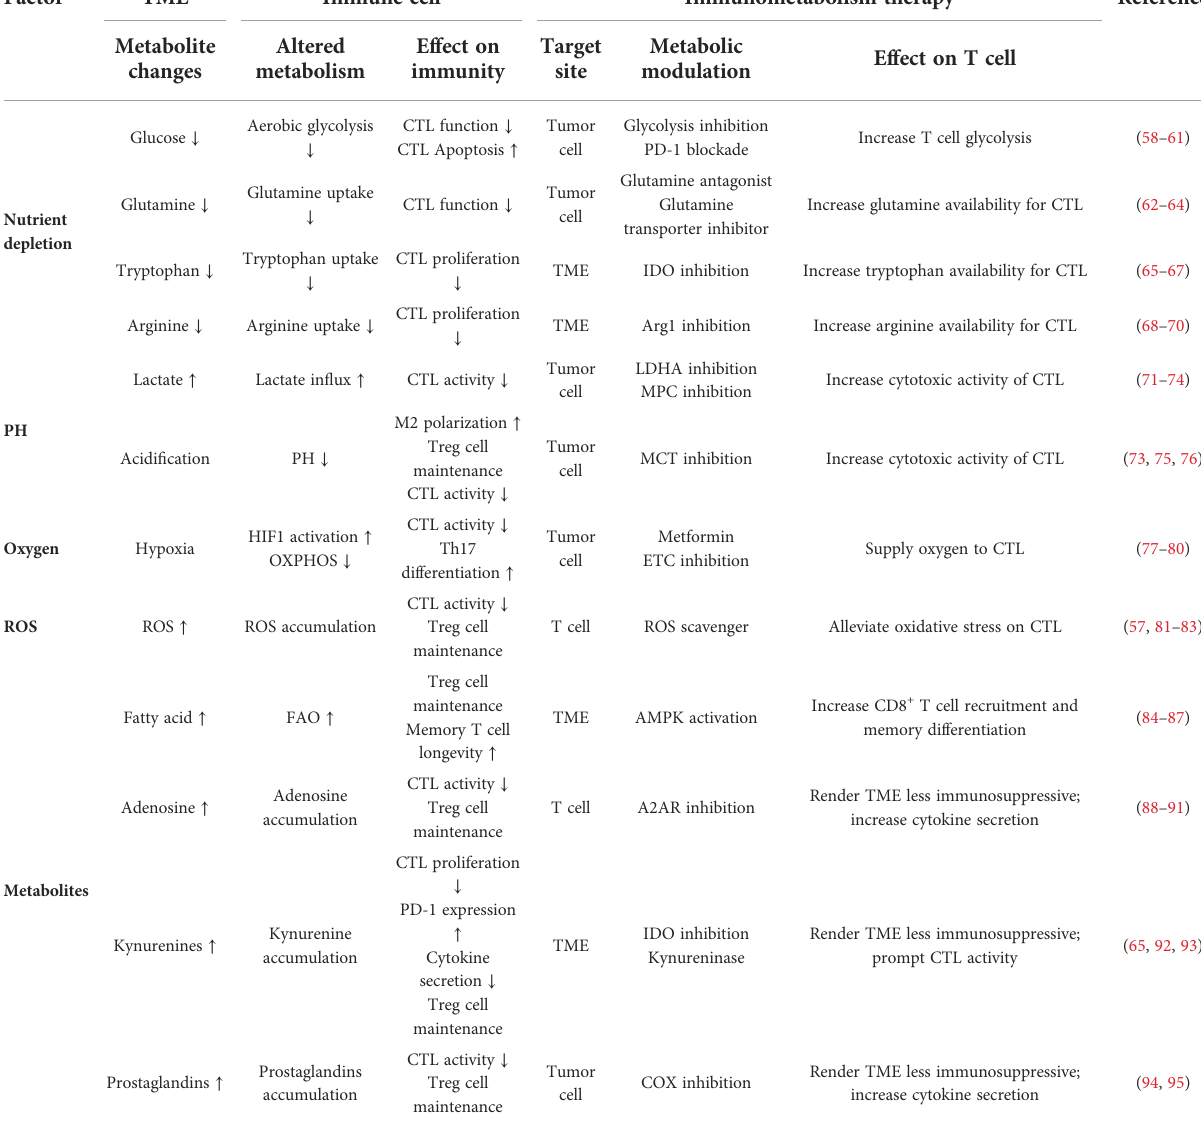
TABLE 2 Effects of metabolic changes of the TME on immune cell function and potential immunometabolism therapies.